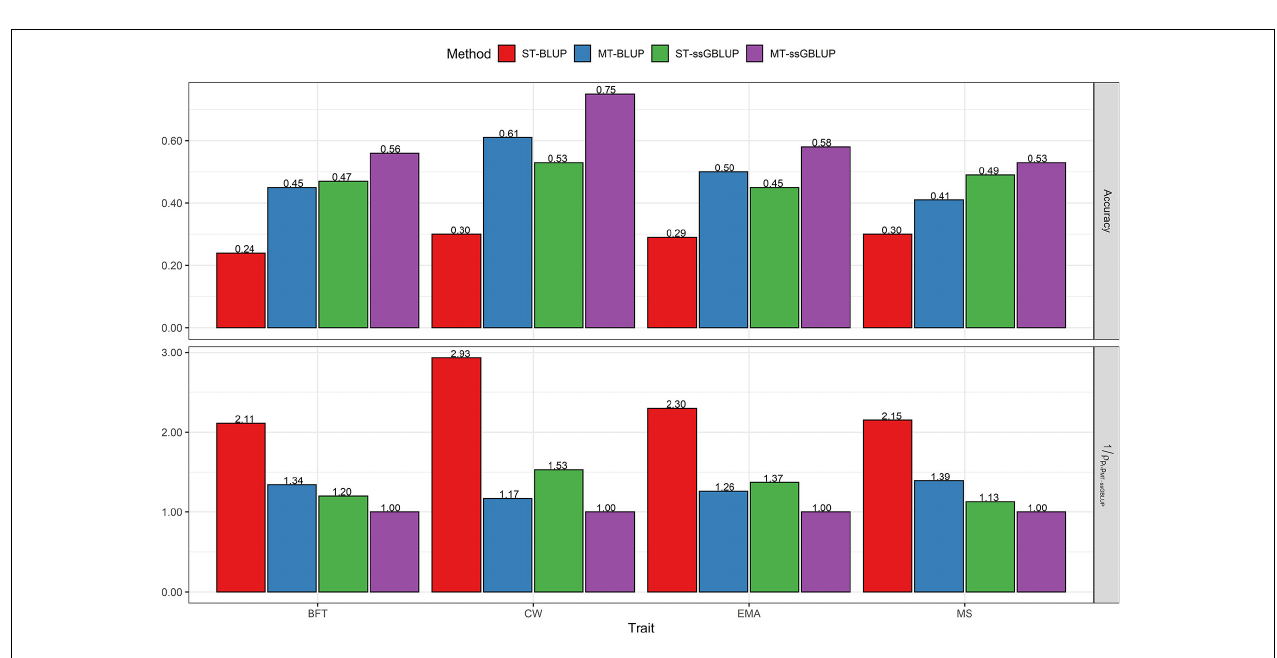
: the relative pi , pMT − ssGBLUP